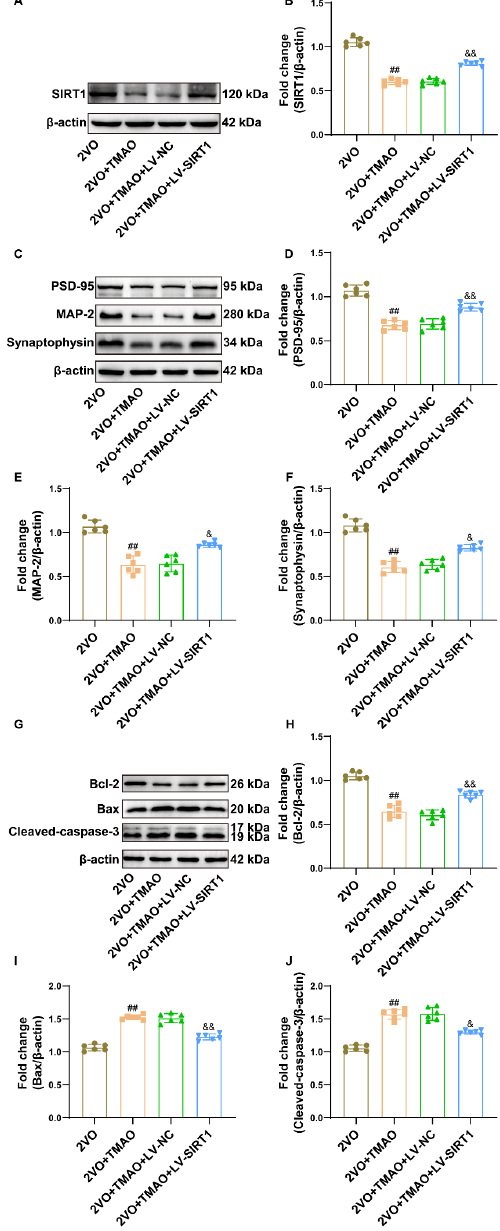
Figure 8. TMAO reduced synaptic plasticity and promoted neuronal apoptosis by inhibiting SIRT1 within 2VO rats. ( A ) Representative bands for SIRT1 protein expression within the rat hippocampi across the groups (n = 6). ( B ) Quantification for SIRT1 protein expression is shown as a bar chart (n = 6). ( C ) Representative bands of PSD95, MAP-2, and synaptophysin protein expression within the rat hip- pocampi across the groups (n = 6). Quantification for ( D ) PSD95, ( E ) MAP-2, and ( F ) synaptophysin protein expression is shown as a bar chart. β -actin served as a loading control (n = 6). ( G ) Repre- sentative bands for Bcl-2, Bax, and cleaved caspase-3 protein expression within the rat hippocampi across the groups. β -actin served as a loading control (n = 6). Quantification for ( H ) Bcl-2, ( I ) Bax, and ( J ) cleaved caspase-3 protein expression is shown as a bar chart (n = 6). Datasets reflect the mean ± SD. ## p < 0.01 versus the 2VO group; & p < 0.05 and && p < 0.01 versus the 2VO+TMAO+LV-NC